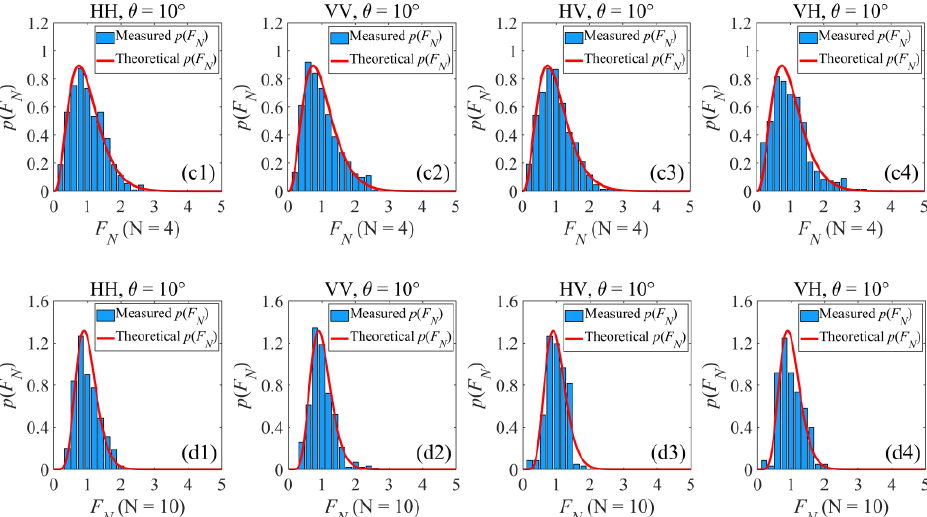
Figure 10. Measured and theoretical PDFs of the backscatter from rice field Scene 2 with full-polarization at an incidence angle of 10 ◦ for square-law detection when ( a1 – a4 ) N = 1; ( b1 – b4 ) N = 2; ( c1 – c4 ) N = 4; ( d1 – d4 ) N = 10. Table 3. Statistical results of the backscatter from rice field scene 2 when N = 1, 2, 4, and 10, for linear and square-law